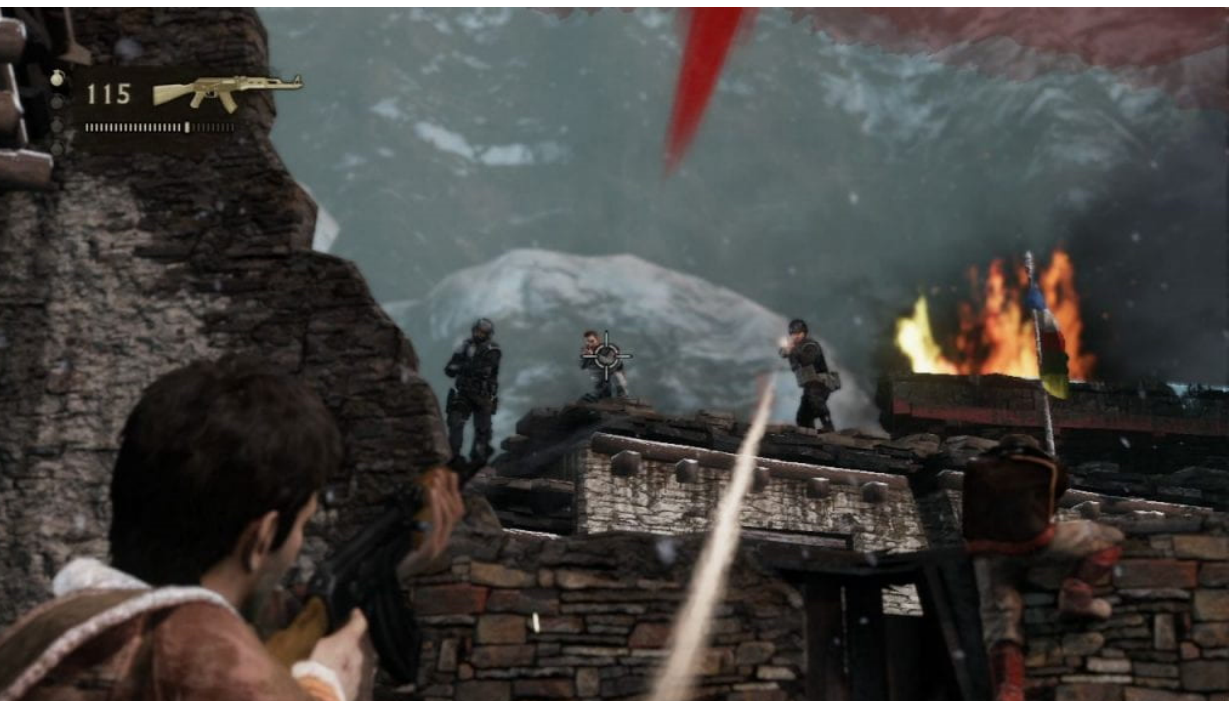
Figure 12. In third-person videogames like Uncharted 2 , the player must look back and forth between the diegetic and non-diegetic frame. (Screenshot created by author).